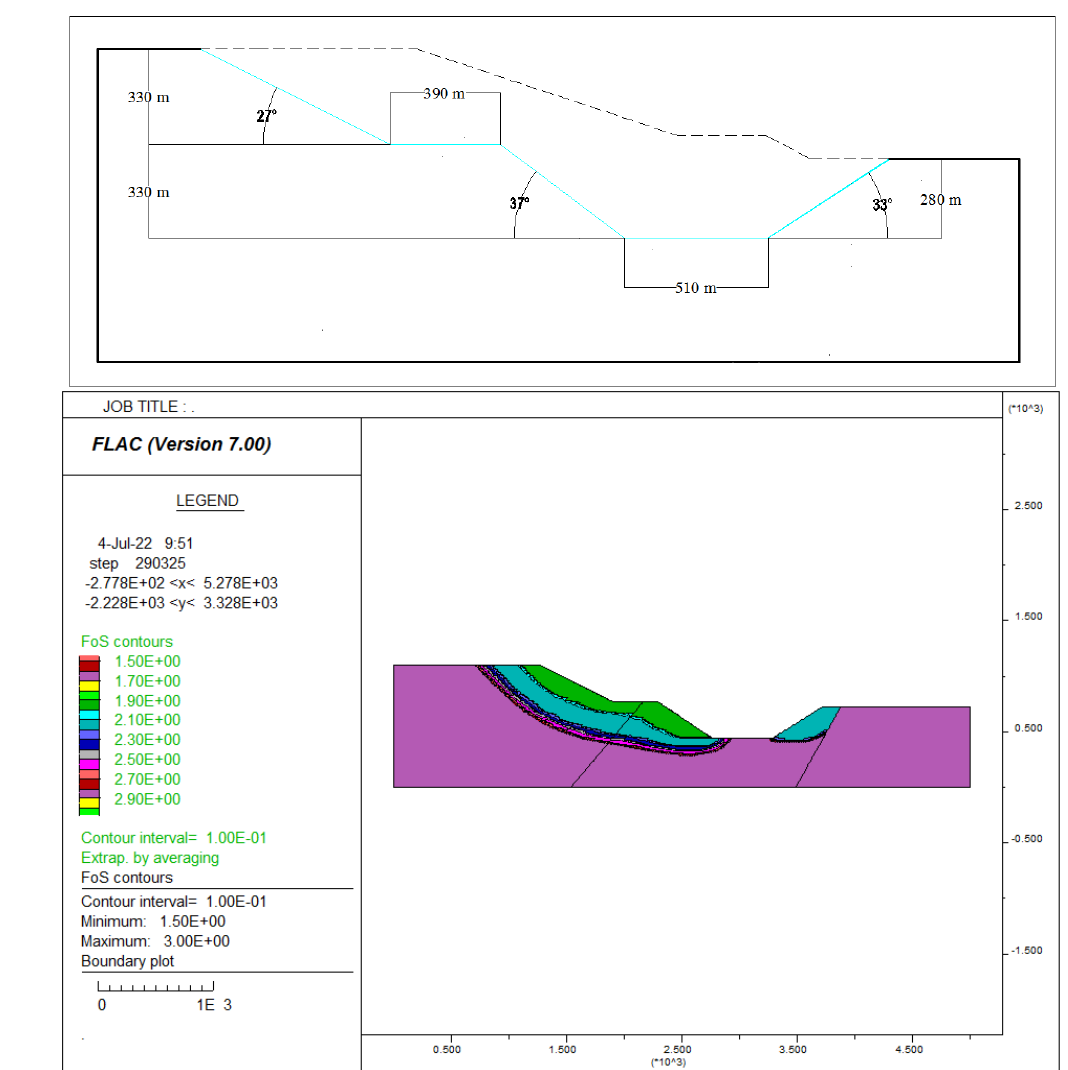
Figure 7: Pit slope in 2030: (a) scheduled geometry, (b) FoS contours and slope failure